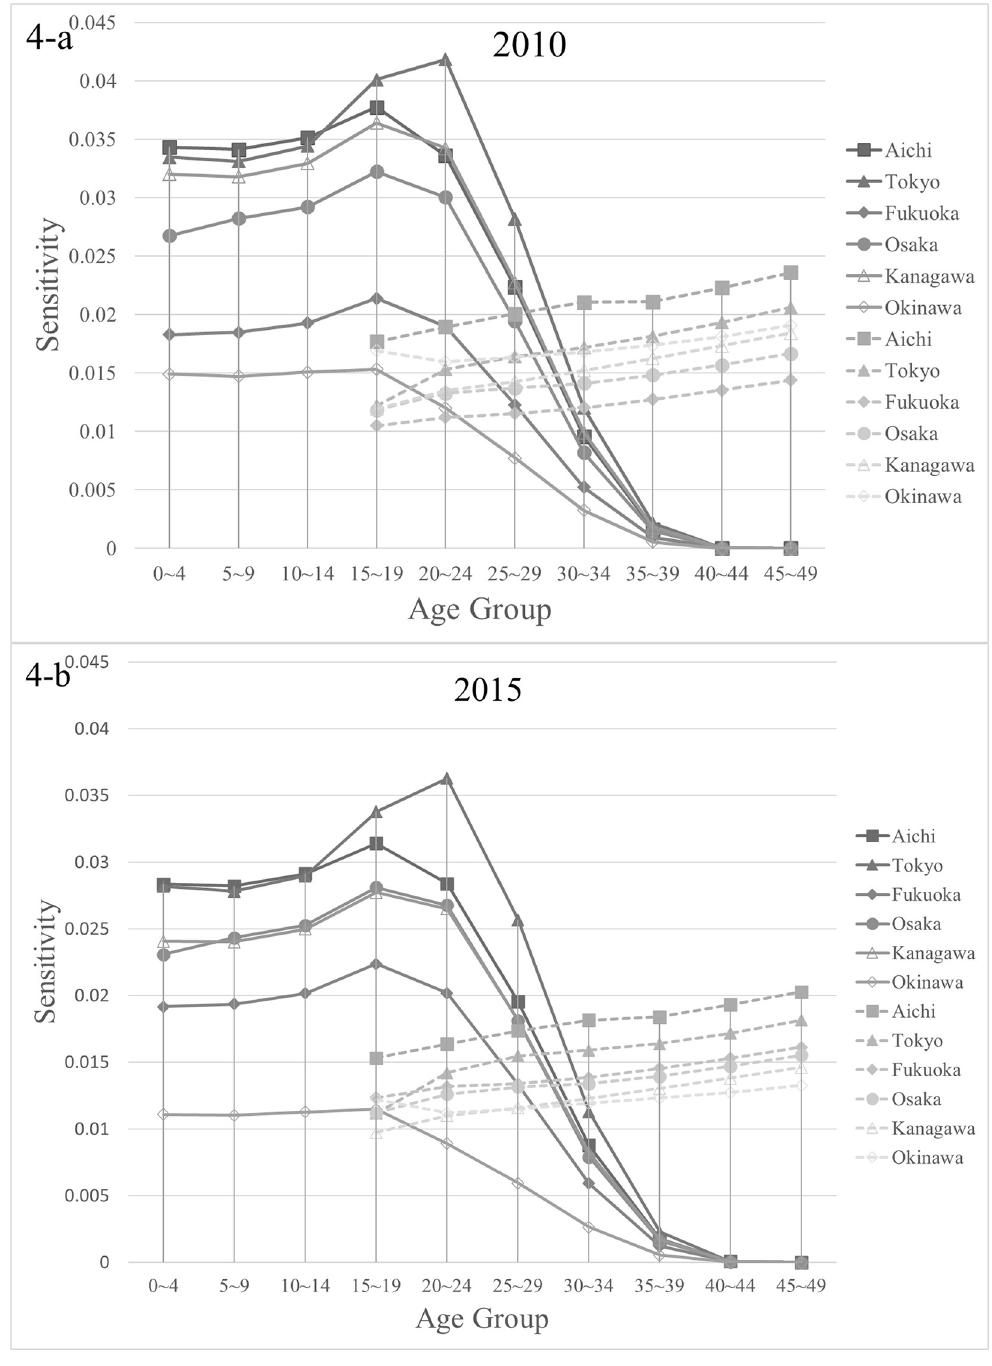
Fig 4. Comparison with sensitivity in